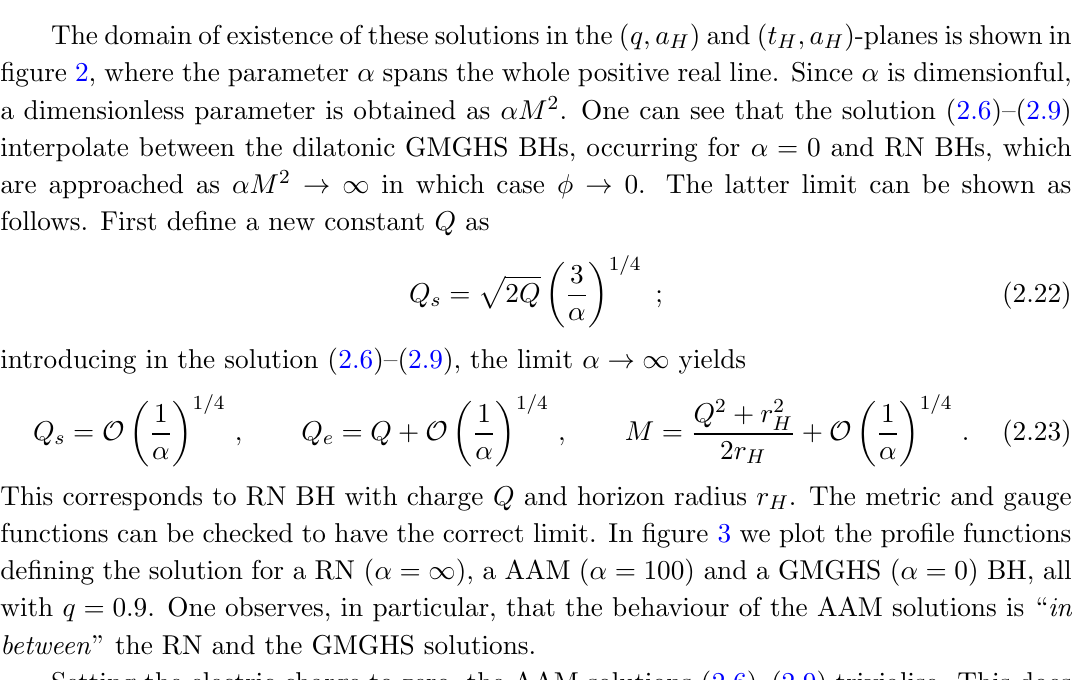
Figure 2 . Domain of existence of the AAM BH solutions in a reduced area vs. q (left panel) or t H (right panel) diagram | shaded region. The RN (GMGHS) limit is given by the dashed blue (solid red) lines. Black dashed lines correspond to (cid:11)M 2 =constant. The solid green line corresponds to the extremal